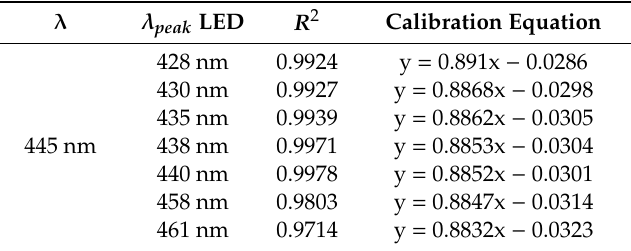
Table 2. 445 nm fit quality comparison using different LEDs.